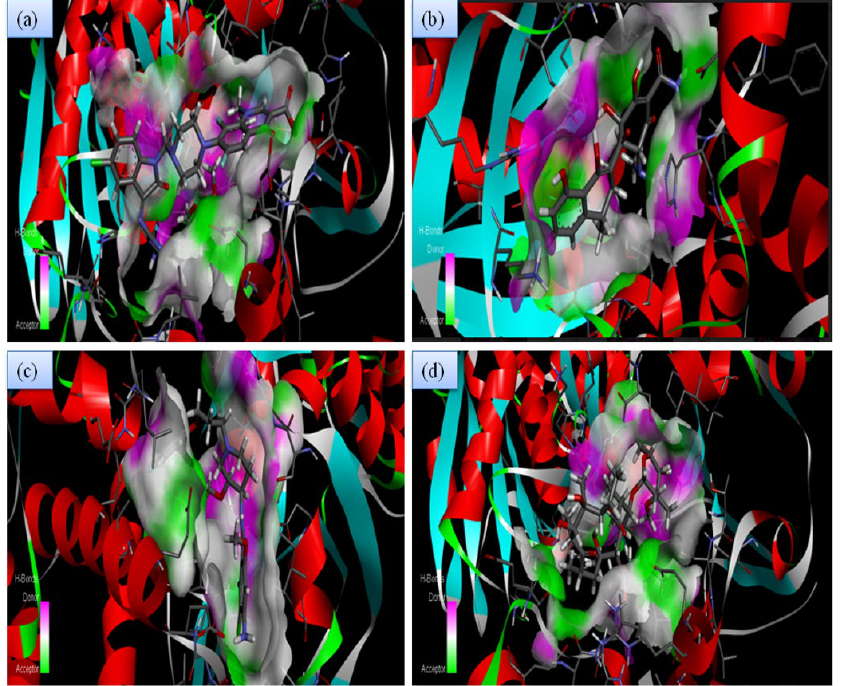
Fig. 3A. H-Bonding interaction of compound with the active site of Chorismate synthase protein (1UMF). (a) Fluoroquinolone (FLRQ). (b) Tetracycline (TET). (c) Cisapride(CSP). (d) Erythromycin